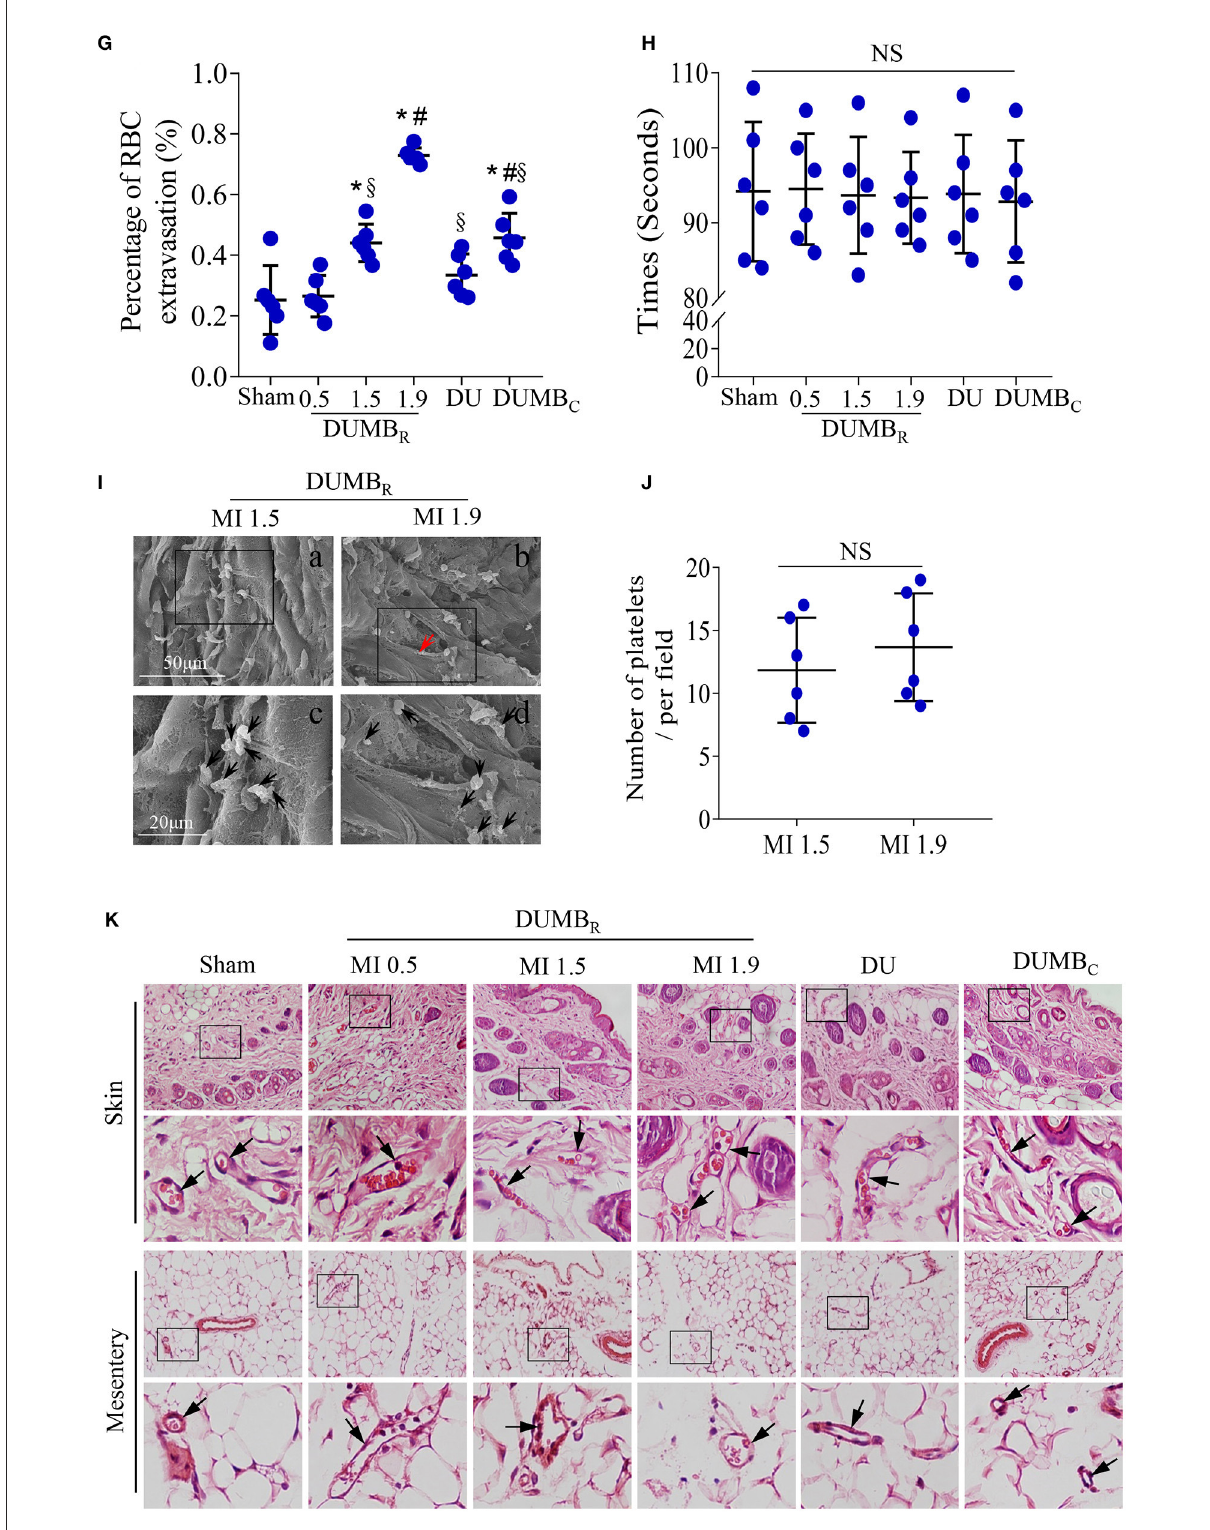
FIGURE4 Effects of DUMB R treatment on plaques: Results of various ultrasonic mechanical index (MI) values. (A) Background-subtracted, color-coded images of ultrasound molecular imaging for MB R or MB C before and 24h after treatment. Representative images of